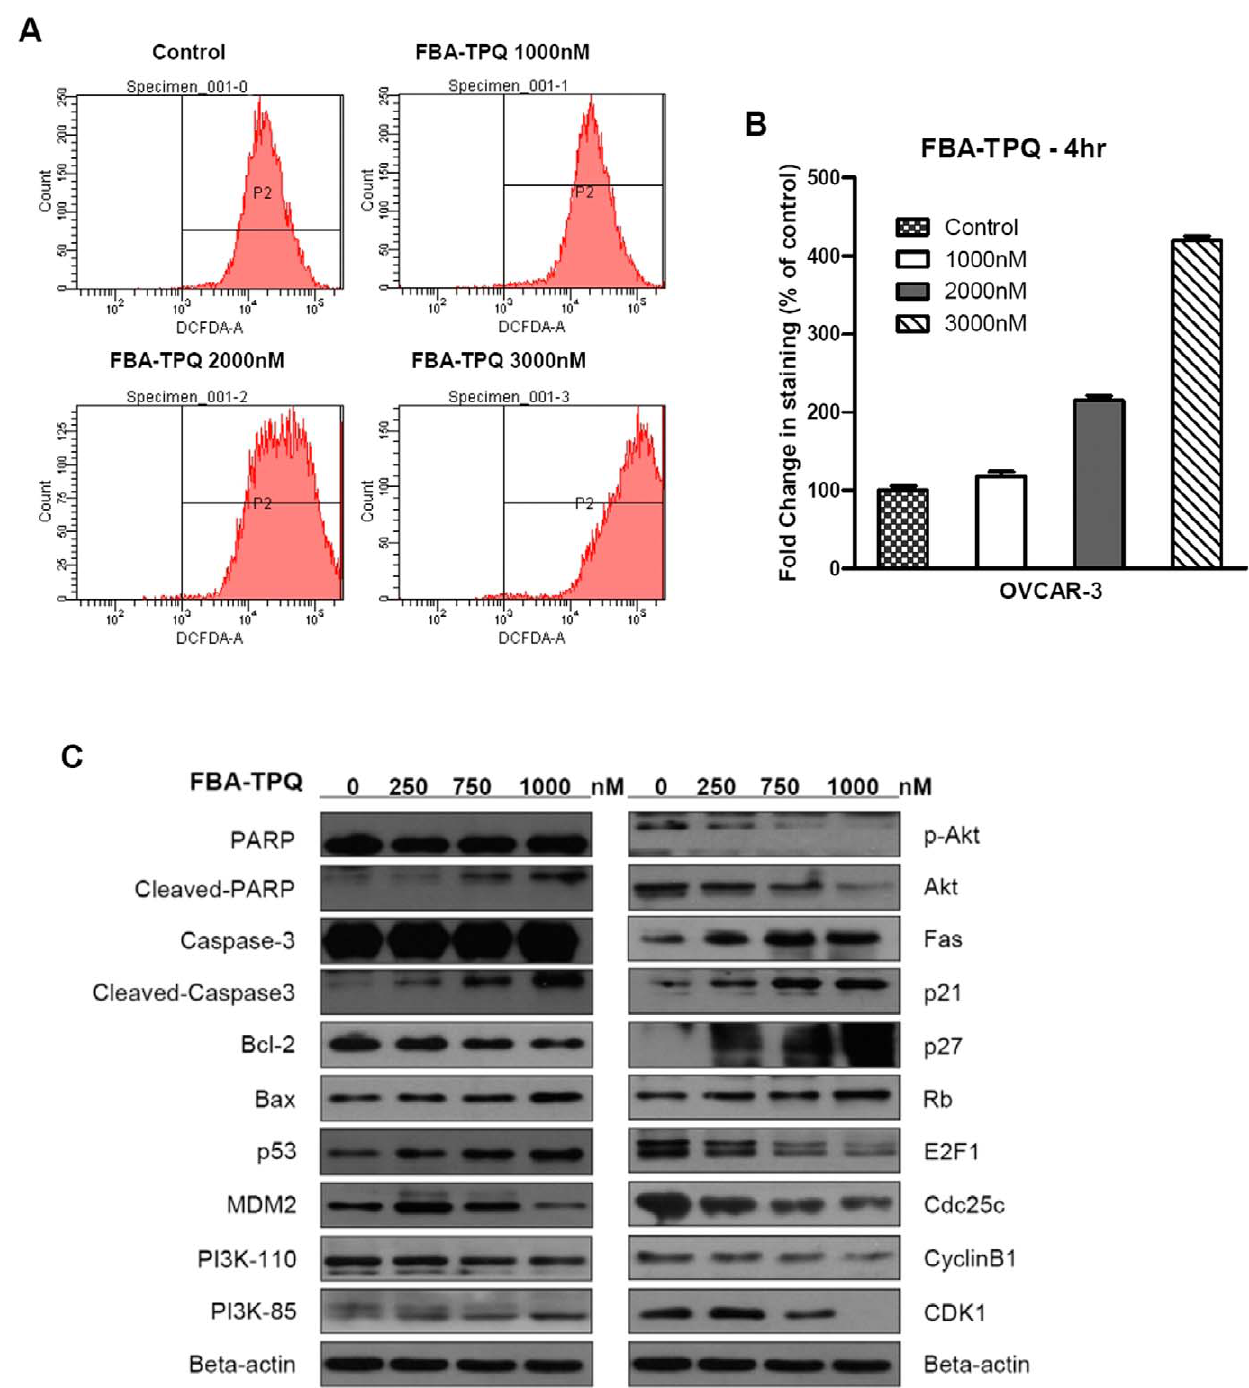
Figure 3. FBA-TPQ induces cellular ROS and regulates the p53-MDM2, and PI3K-Akt mediated pathways. A&B, FBA-TPQ induces dose- dependent ROS stress in OVCAR-3 cells (A, the dose-dependent increase in the ROS as indicated by CM-H 2 DCFDA; B, Data summarized as the percentage compared with the control). C, Western blot analysis of cellular protein expression levels of the related pathway, indicating FBA-TPQ may take effects through the ROS-accompanied, and PI3K-Akt-mediated/p53-MDM2-related cell proliferation, apoptosis and cell cycle progression associated pathway on OVCAR-3 ovarian cancer cell lines after 24 h exposure (at 250,750 and 1000 nM concentrations). doi:10.1371/journal.pone.0020729.g003 DNA damage, regulation of the ‘pathway in cancer’, ‘p53 In conclusion, our study demonstrated that FBA-TPQ can exert potent cytotoxicity and cell proliferation inhibition effects towards signaling pathway’ and ‘phosphatidylinositol signaling system’ (e.g., PI3K-Akt), as well as its negatively regulation of CDK (e.g., A2780 and OVCAR-3 cells. Except for the induction of apoptosis, CDK1 and the related CDC25C and CyclinB1). it can also induce cell cycle arrest and inhibit OVCAR-3 xenograft